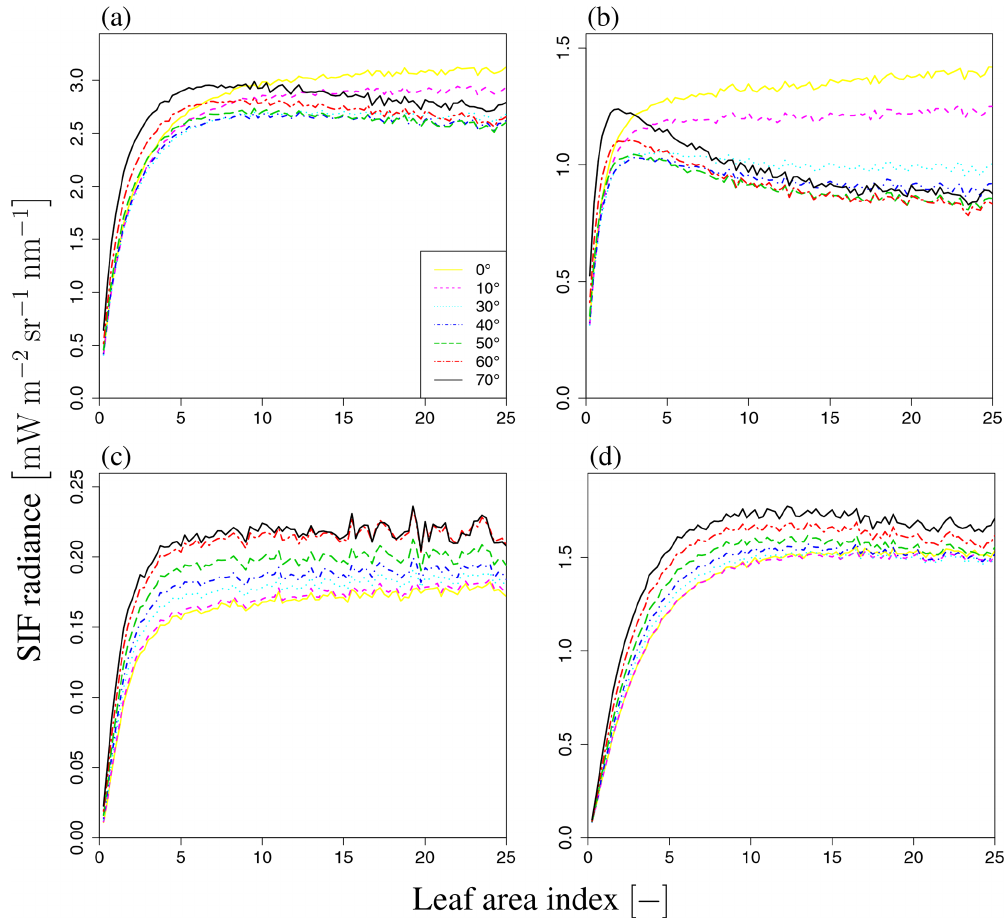
Figure 15. LAI dependence of SIF radiance. (a) Total radiance I , (b) direct radiance from sunlit leaves, (c) direct radiance from shaded leaves, and (d) radiance after multiple scatterings at SZA of 20 ◦ and SAA of 180 ◦ (backward direction). Each line represents a different VZA value (0–70 ◦ ). SIF radiance increases with LAI and then becomes saturated in most cases. However, when VZA is large (e.g., black and red lines), only the direct radiance from sunlit leaves decreases with an increase in LAI, different from the forward direction